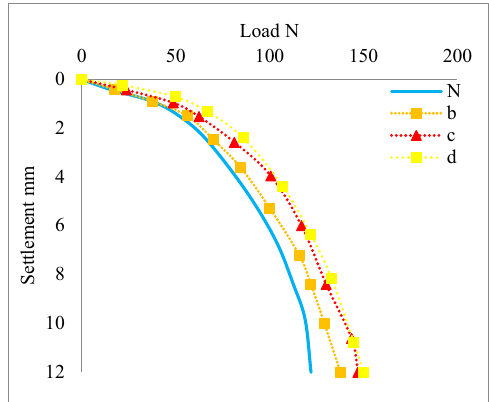
Figure 9: Load – settlement relations for footings resting on soil grouted before footing construction.